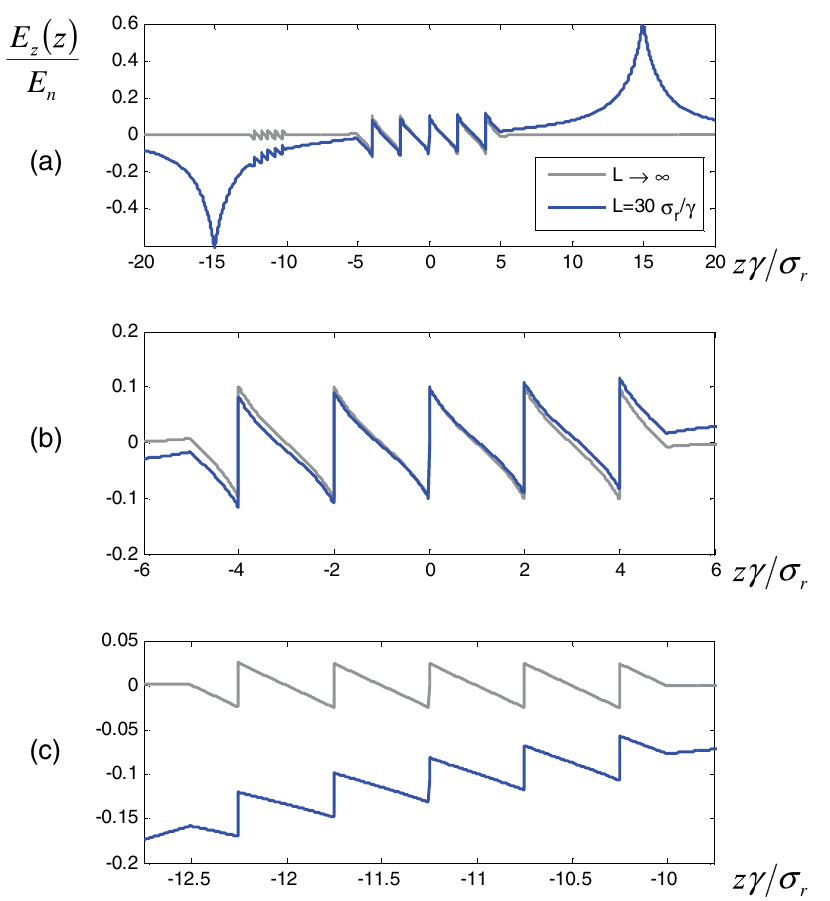
FIG. 2. Longitudinal field E on axis of a bunch with round Gaussian transverse profile. The longitudinal profile is rectangular with z length L , superimposed by two short periodic bursts. Both bursts contain 5 dirac pulses with equidistant spacing. The bunching factor in the periodic intervals is 0.1, or 10 percent of the charge per period is in the dirac pulses. The period length in the bursts is 0 . 5 σ 2 σ Λ = ð 2 πε σ γ Þ with Λ ¼ q=L . (a) Full bunch, (b) detail with burst in the middle, (c) detail with = γ . The field is normalized to E 0 r n ¼ r burst close to the